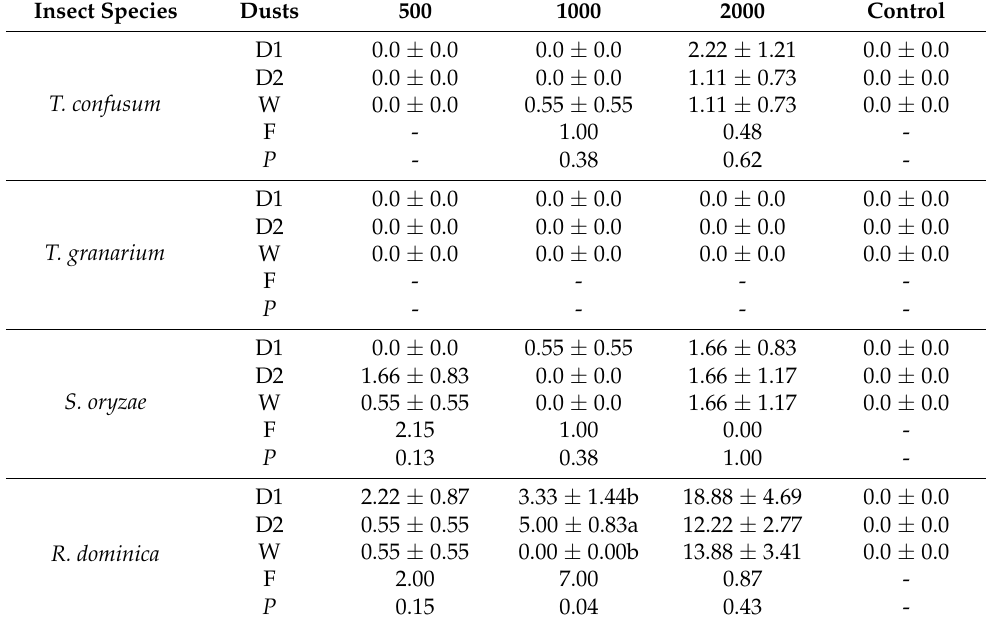
Table 3. Mean mortality (% ± SE) of Tribolium confusum , Sitophilus oryzae , Rhyzopertha dominica adults and Trogoderma granarium larvae after exposure to three different dust formulations (D1, D2, and W) applied at four concentration rates (500, 1000, 2000 ppm, and control) for 1 day (in all cases d.f. = 2.26). Insect Species